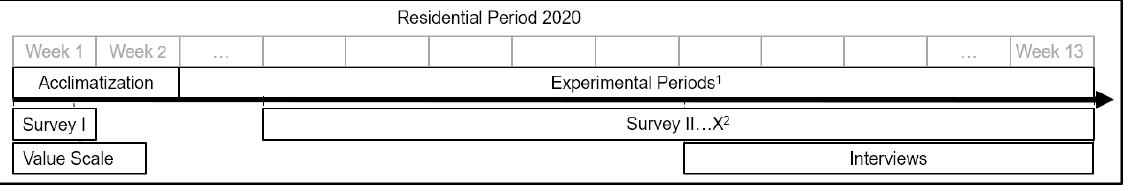
Figure 2. Schematic overview of the residential period